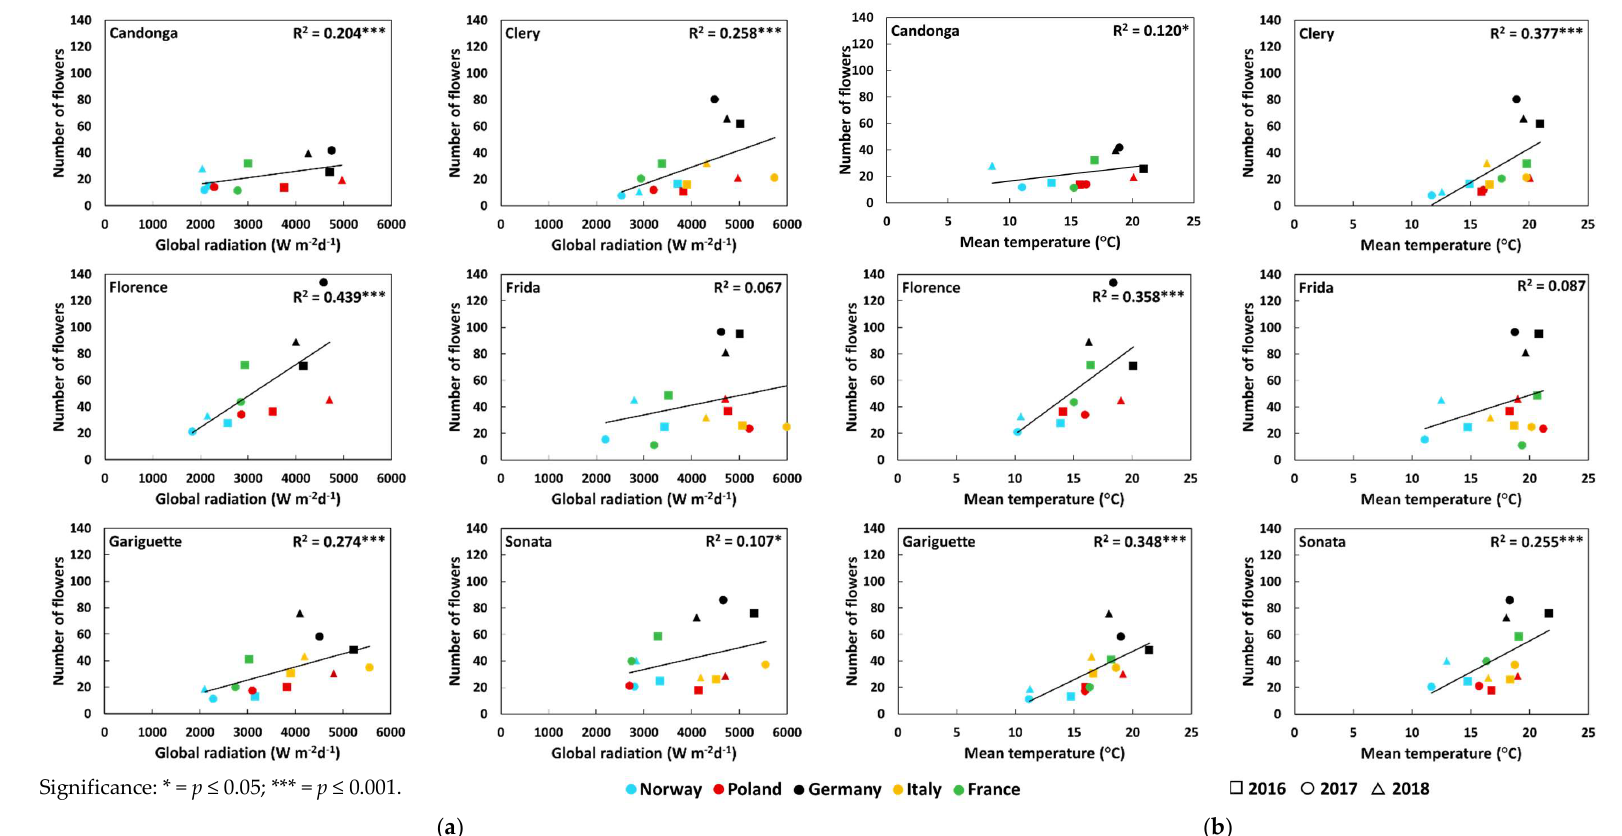
Figure 4. Number of flowers of six cultivars grown at five locations in Europe as influenced by ( a ) global radiation and ( b ) mean temperature during the 3-week period preceding flower initiation in 3 years.